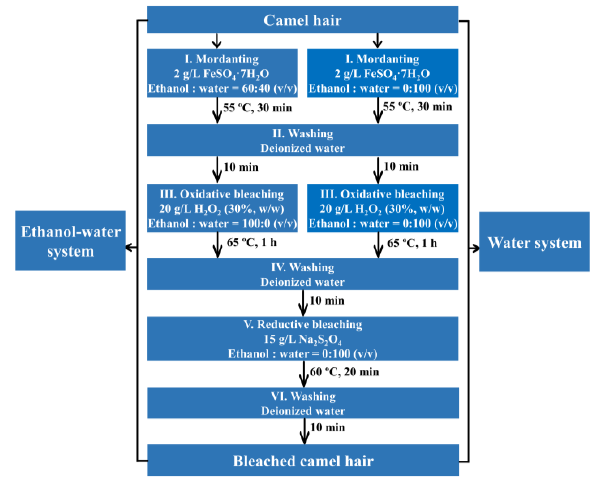
Figure 2. Flow chart for bleaching of camel hair in the ethanol–water and water systems.